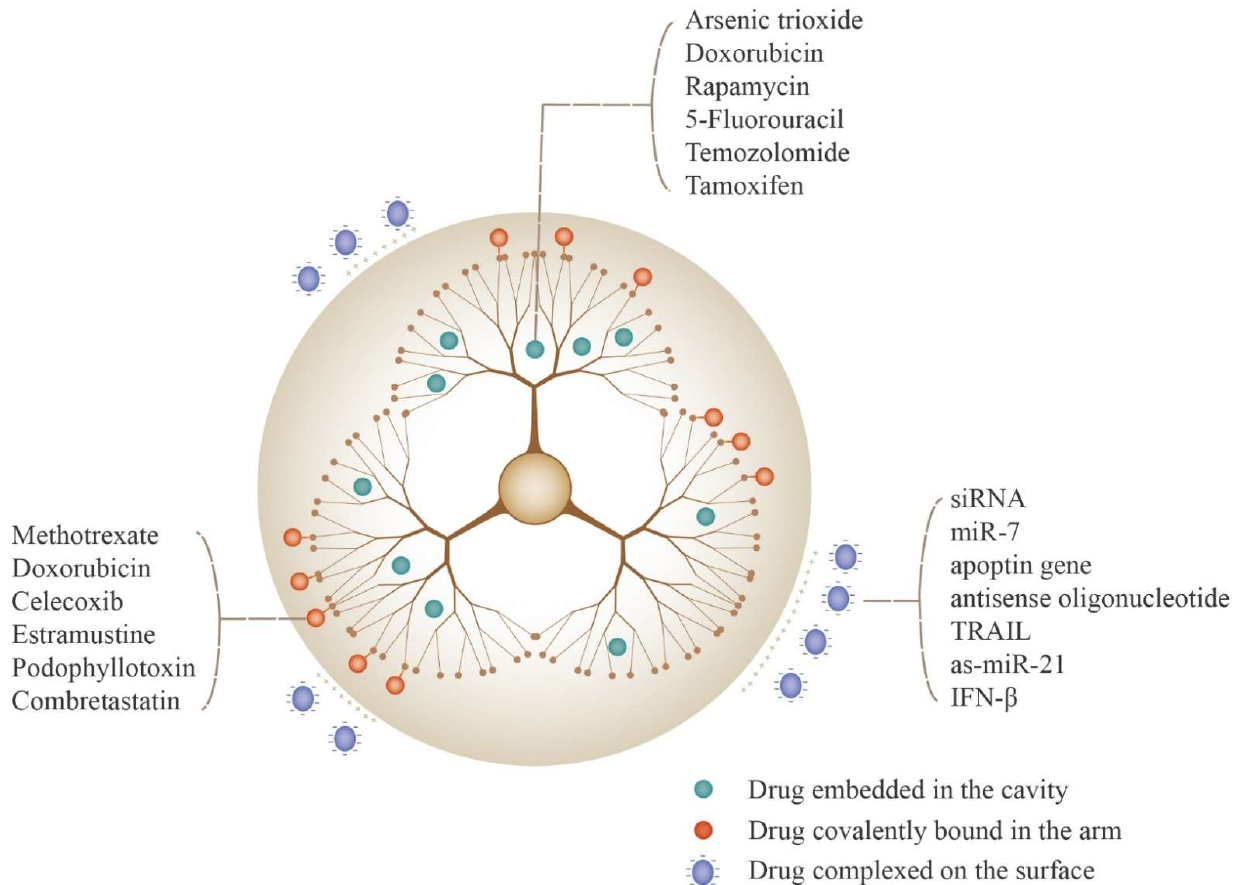
Figure 2. Methods of loading drugs in PAMAM DDS. Drugs can be embedded in the PAMAM’s cavity or complexed on the surface of PAMAM or covalently bound in the arm of PAMAM. SiRNA: small interfering RNA; miRNA-7: microRNA-7; TRAIL: tumor-necrosis-factor-related apoptosis-inducing ligand; IFN-β: interferon-β.